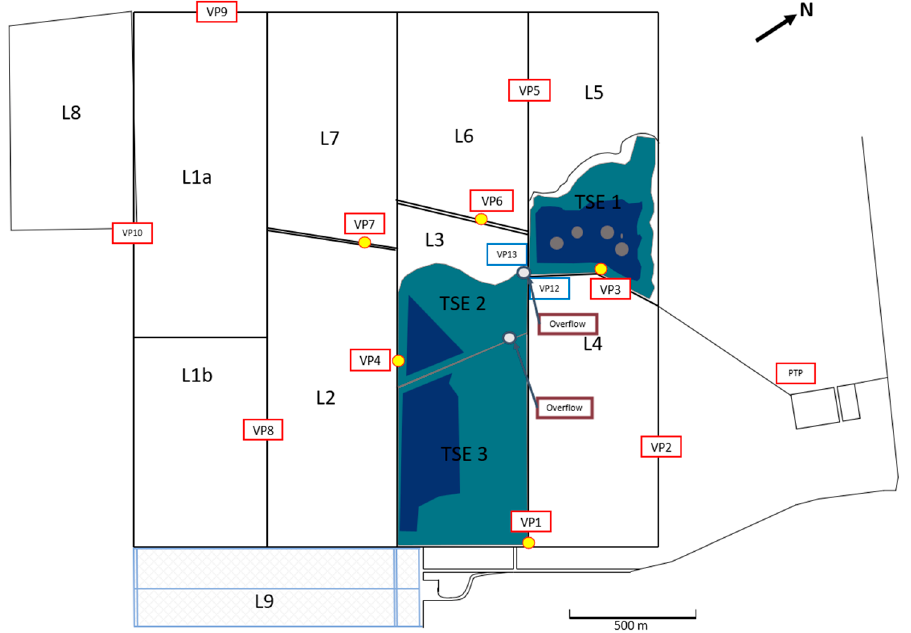
Figure 3. Map of Al Karaana Lagoons project area. L1a through L8 are the names of the former wastewater ponds. All but part of L3 and L5 have been restored back to their original state of compact sandy soil. Treated sewage effluent pond (TSE)-1 is located in a part of the original L5 basin, while TSE-2 and TSE-3 are situated in the former L3. The teal blue and dark blue areas represent the TSE ponds post-remediation, with greater depth indicated by the dark blue. Pre-remediation (2017) survey vantage points (VPs) are also marked. The package treatment plant (PTP), where the water is purified, is shown on the right. TSE-1 has a shallow area; TSE-2 has relatively steep sides with no shallow areas; TSE-3 has a shallow area by the inlet on the eastern side, while the greatest depth is located in the southern end (Table S1). As of the end of the study (September 2021), reeds have completely surrounded TSE-1 and TSE-2 and extended to the northeastern edge of TSE-3. At